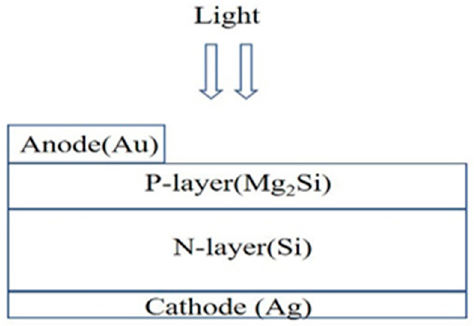
Figure 1. The schematic diagram of the Mg 2 Si/Si heterojunction PD. Table 1. The optical and electrical material parameters for Mg 2 Si and Si.